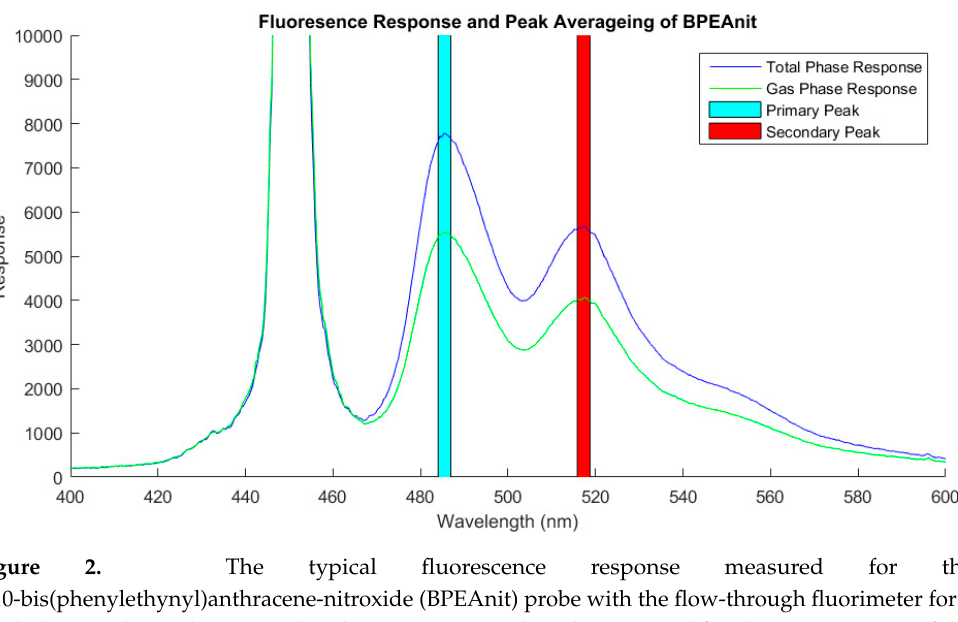
Figure 2. The typical fluorescence response measured for the 9,10-bis(phenylethynyl)anthracene-nitroxide (BPEAnit) probe with the flow-through fluorimeter for a total phase and gas phase sample. The response wavelengths averaged for the measurement of the primary and secondary peaks are indicated by the blue and red shaded regions, respectively. The large third peak centred on 450 nm is the laser used as the excitation source.